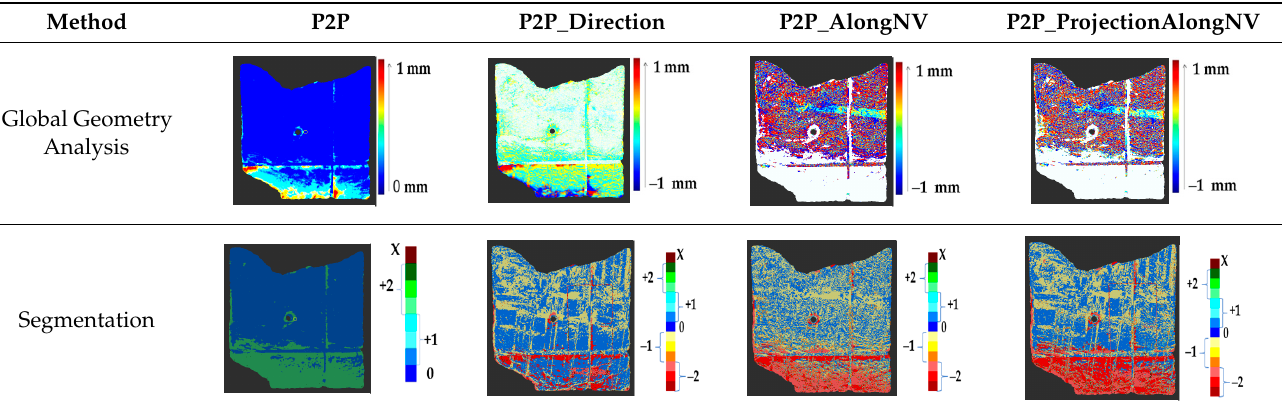
Table 20. Analysis of surface points count on the surface of NBL2.